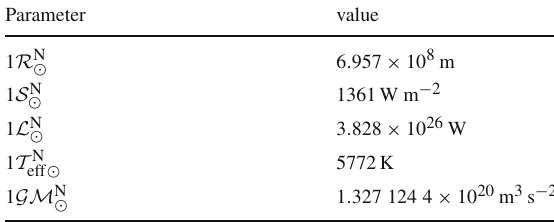
Table 2 Nominal solar conversion constants as per IAU resolution